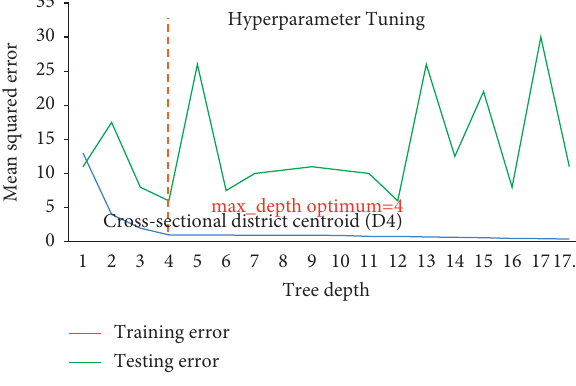
Figure 12: Hyperparametric tuning of DTR for D4. Table 3: Integrating the DTR and RFR with evaluation metric and information criteria. Datasets